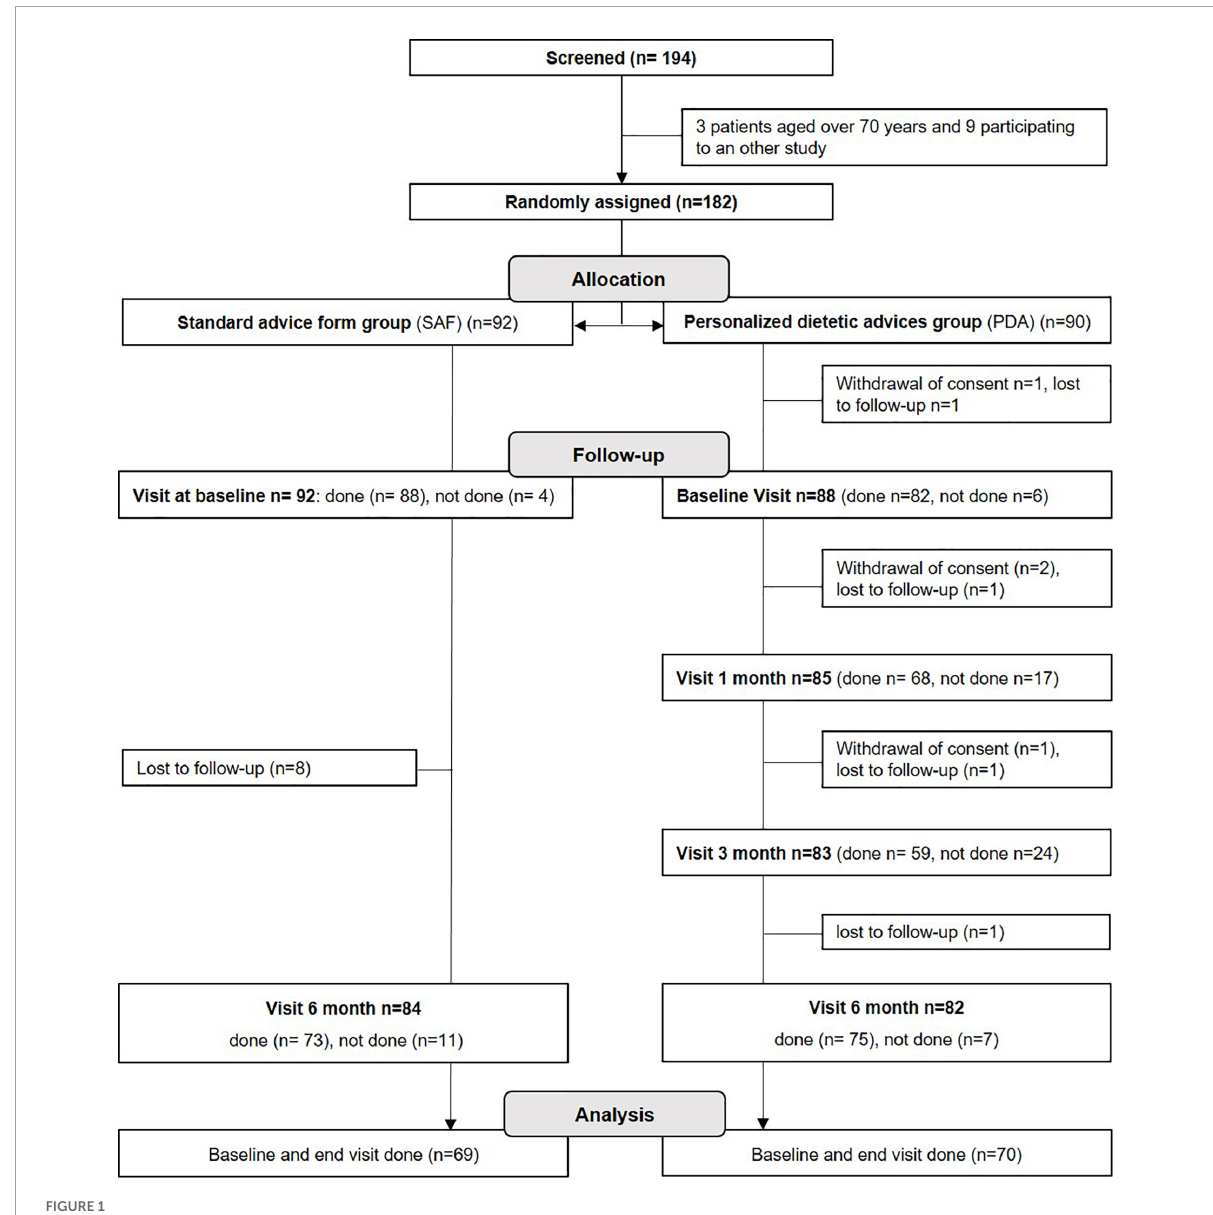
FIGURE1 Study flow